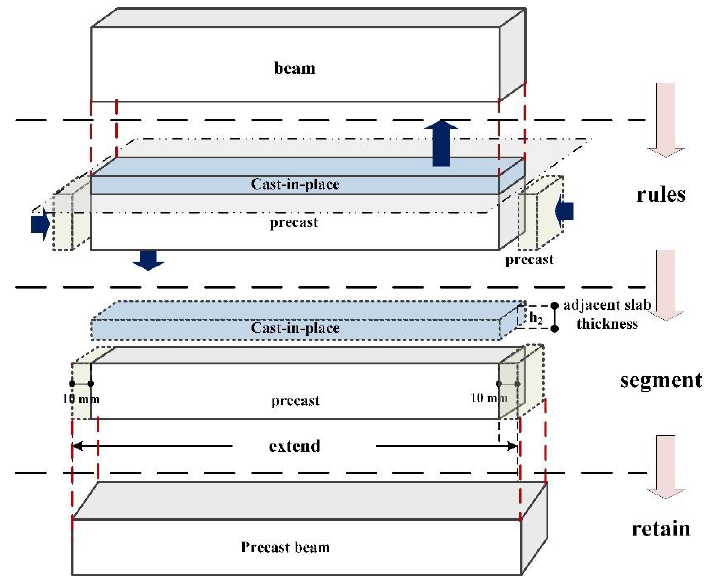
Figure 14. Segmentation of a beam model.